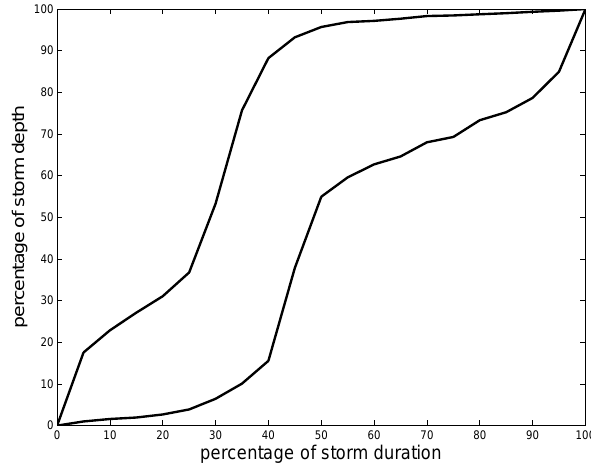
Figure 3. Huff curves for the second-quartile autumn storms. The 10% (lower) and 90% (upper) percentile curves are